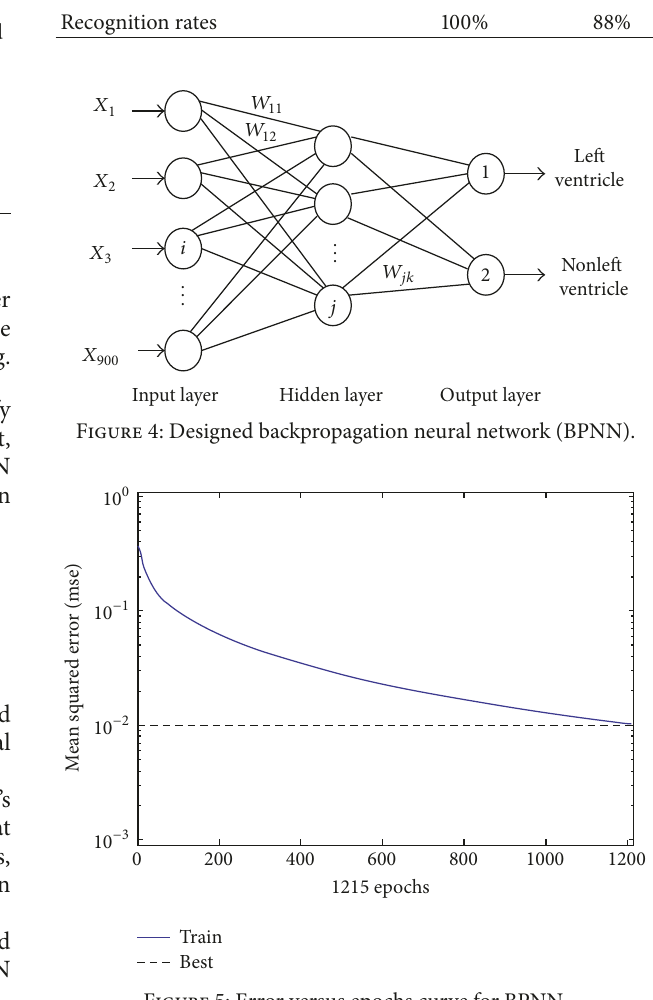
Figure 5: Error versus epochs curve for